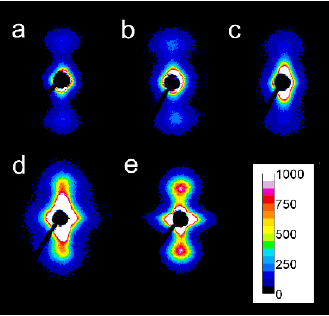
Figure 9. 2D-SAXS patterns of PLLAs: sheared at 150 °C at 20 /s for 5 s and cooled at 10 °C/min: L121 ( a ), 4S123 ( b ), 6S120 ( c ), L240 ( d ), 6S245 ( e ). Shearing direction – vertical.